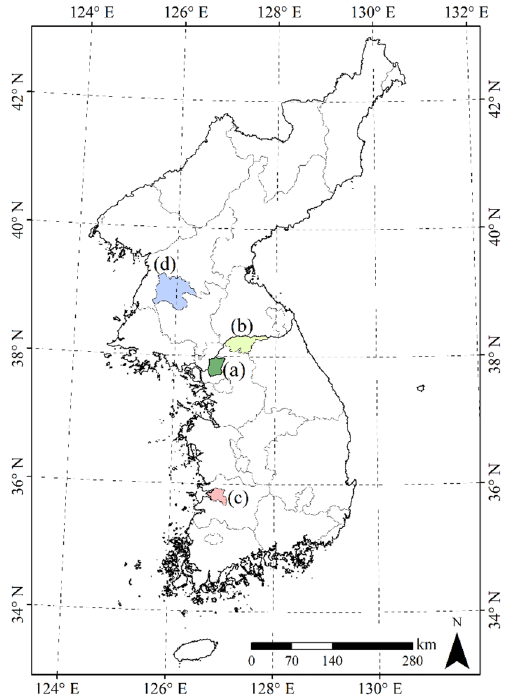
Figure 4. Study location boundary maps of ( a ) Cheorwon, ( b ) Paju, ( c ) Gimje in South Korea and ( d ) Pyeongyang in North